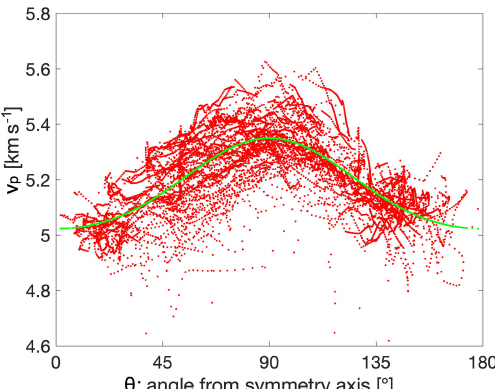
Figure 9. Apparent velocities (source–receiver distance divided by travel time) plotted in red against the angle from the anisotropic symmetry axis. The green dots/line show the prediction of the fitted anisotropic velocity model (Eq. 1). The difference between the red and green dots is evidence for the heterogeneity of the rock and used in the 3-D inversion for v 0